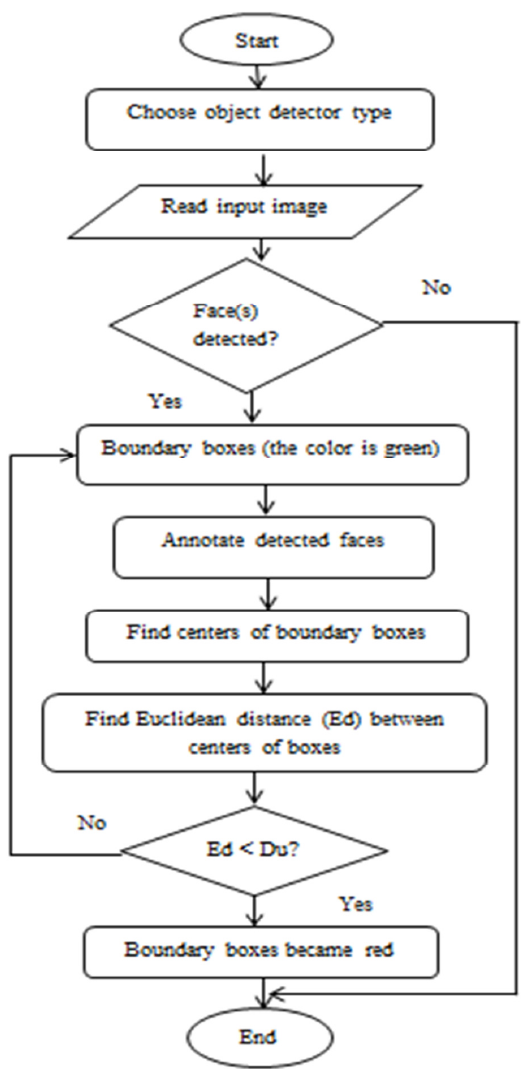
Fig. 3. Flowchart of the system.